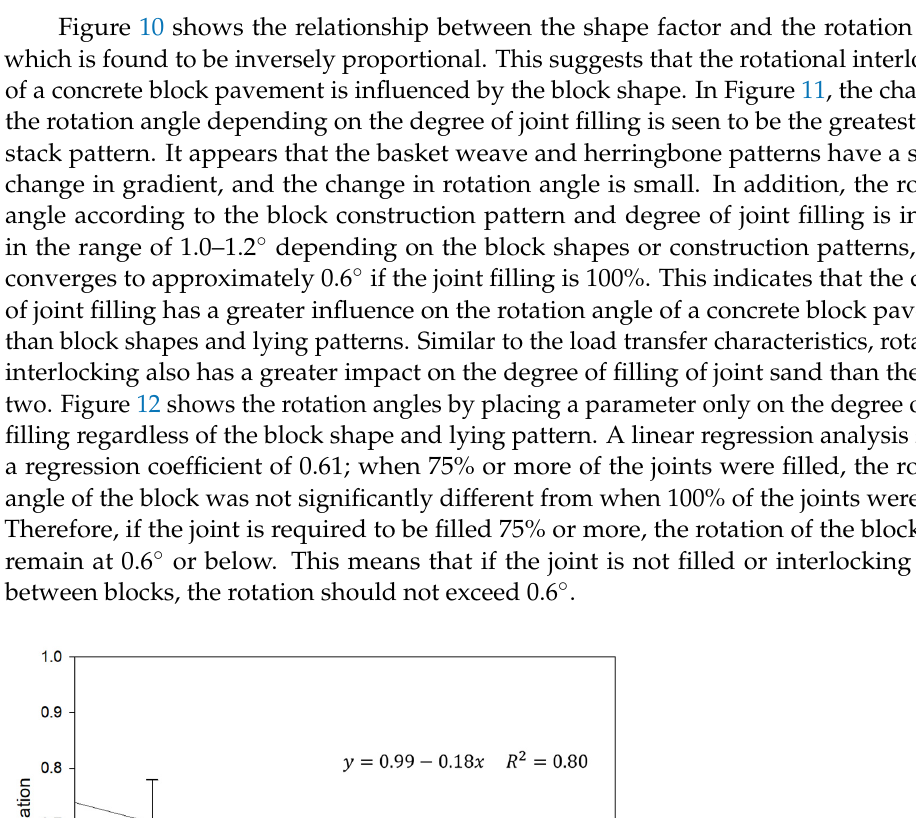
Figure 12. Rotational angles according to degree of joint filling.